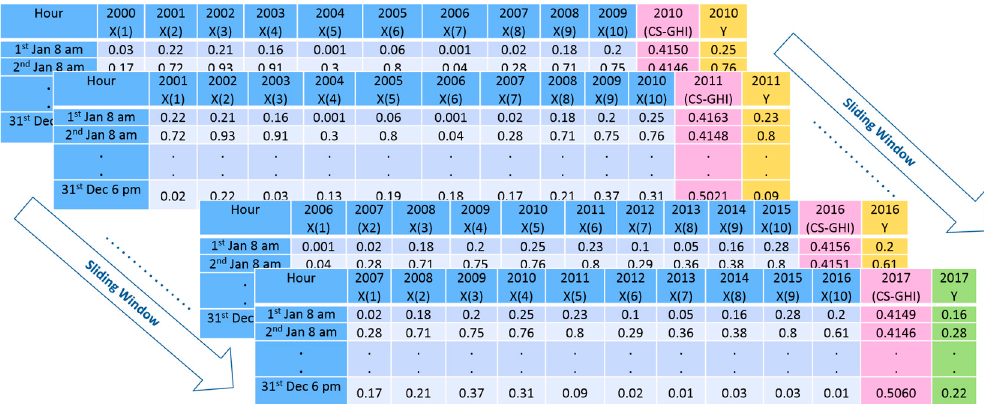
Figure 5. Input data to the model for training and testing.